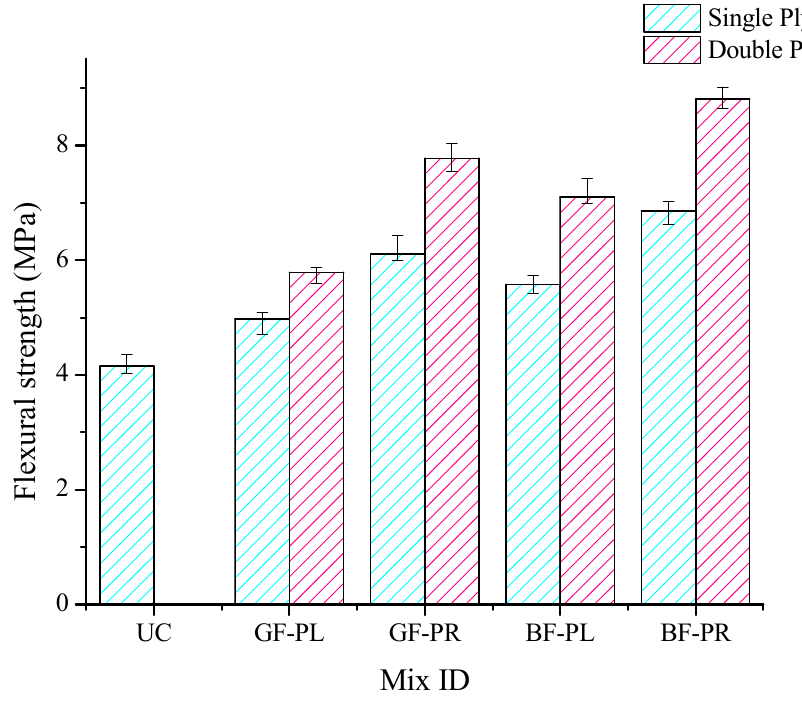
Figure 14. Flexural strength.